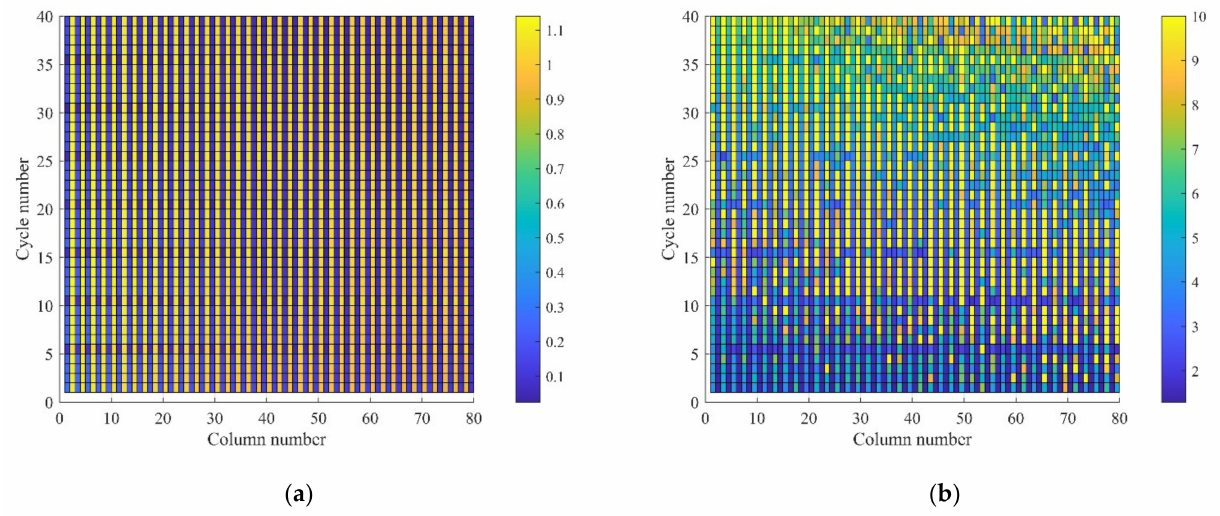
Figure 10. The global diagram for ( a ) standard deviation and ( b )